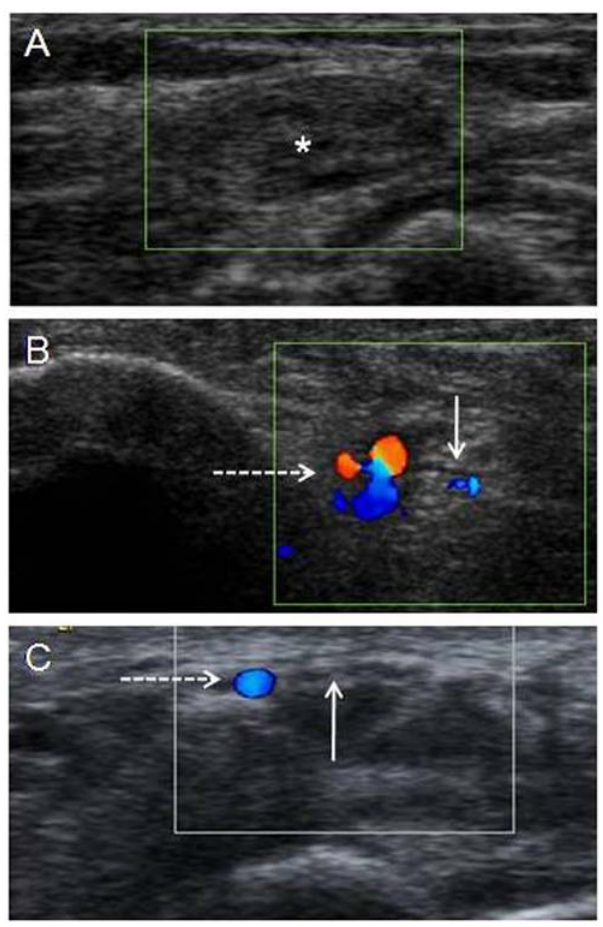
Figure 3. Ultrasonography and color Doppler images of peripheral nerves of leprosy patients. A transverse scan of an enlarged ulnar nerve indicated by an asterisk (CSA=45 mm 2 ) from BT leprosy patient with type 1 reaction showing no endoneural blood flow signals; B colour Doppler image of a right ulnar nerve in a BT patient (CSA=51 mm 2 ) undergoing type 1 leprosy reaction, showing increased endoneural and perineural blood flow signals (demarcated by solid arrow in a rectangular box, dashed arrow in a box shows a blood vessels) suggestive of acute neuritis; C colour Doppler image of a median nerve (shown by solid arrow) in a BT patient (CSA=9 mm 2 ) undergoing type 1 leprosy reaction with persistent artery (shown by dashed arrow), showing no endoneural flow